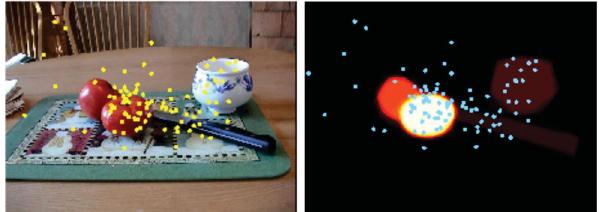
Fig. 1 An example image in Borji et al. ’s experiment [26] along with annotated salient objects. Dots represent 3-second free-viewing fixations.